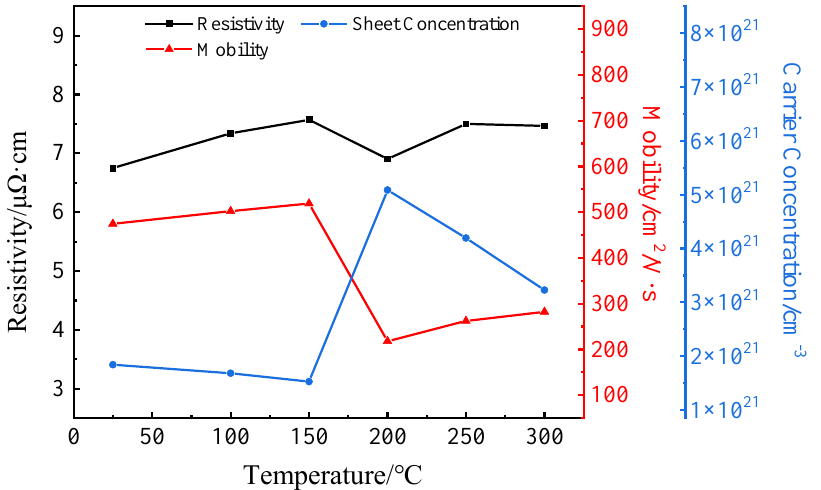
Figure 5. Hall measurement of the ITO/AgIn/ITO films as a function of sputtering temperature.